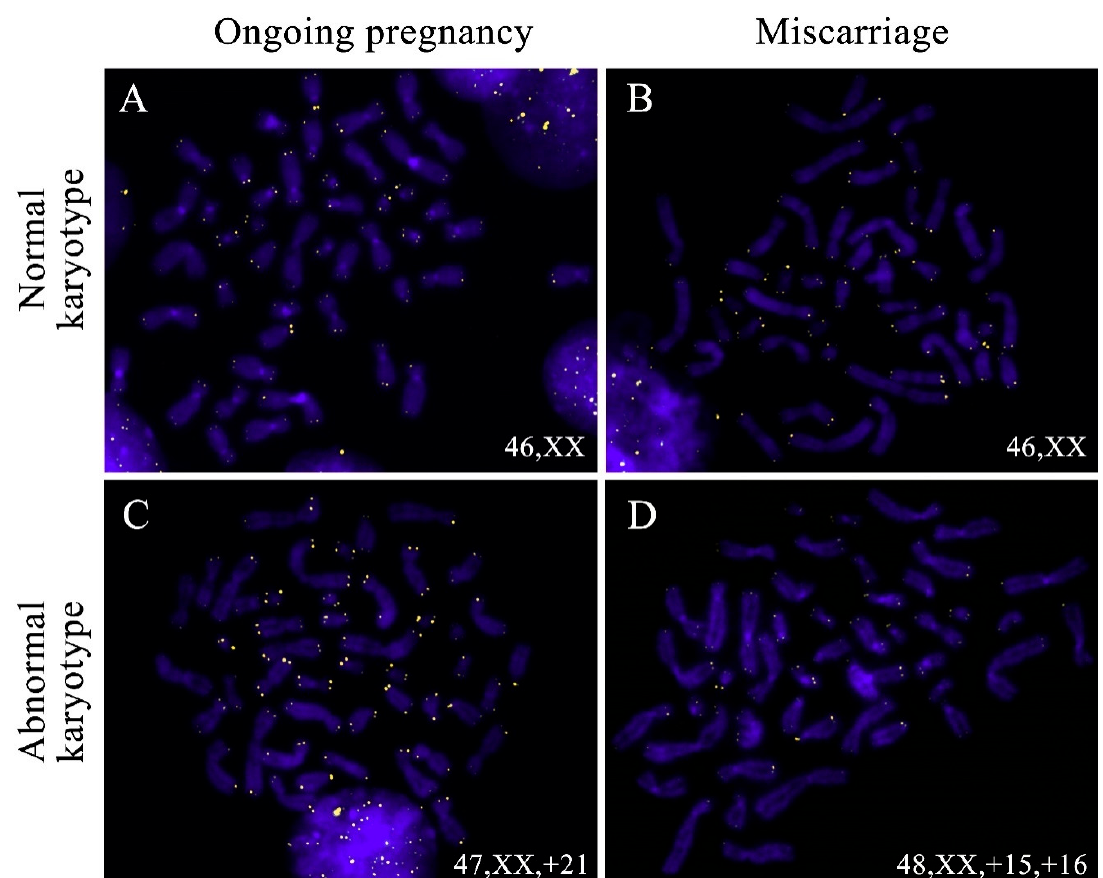
Figure 3. Telomere detection in the metaphase chromosomes from chorionic cytotrophoblast cells in karyotypically normal ( A , B ) and abnormal ( C , D ) miscarriages ( B , D ) and ongoing pregnancies ( A , C ). Telomeres were detected through fluorescent in situ hybridisation (FISH) with telomeric DNA probes, and the chromosomes were stained with DAPI.